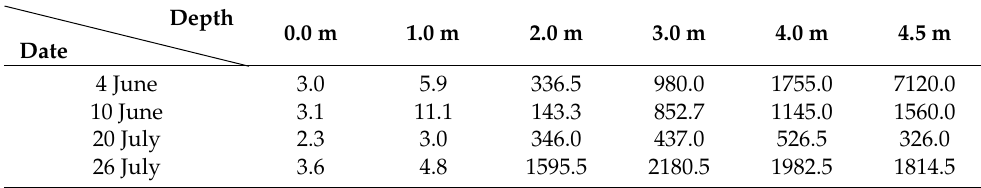
Table 2. Variation in sludge concentration (in units of mg/L).